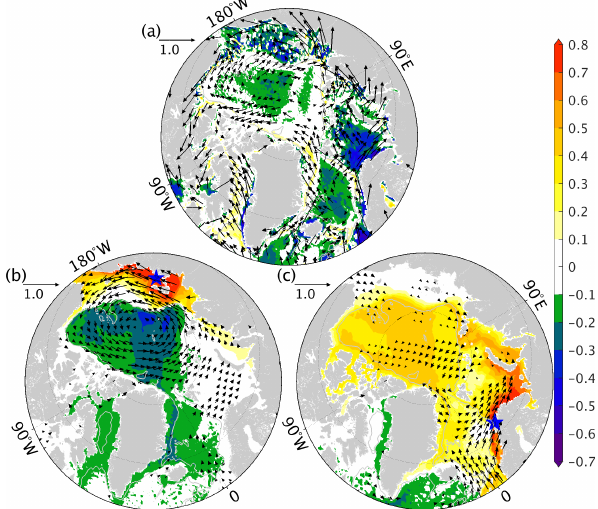
Figure 6. (a) Coefficients of the correlation between sea level anomalies and wind stress curl (shading), wind stress (vectors) at periods of < 30d. (b) Correlations of sea level anomalies in subre- gions of the East Siberian Sea (blue star in panel b ) to wind stress (vectors) and sea level anomalies (shading). Panel (c) is the same as panel (b) but for sea level anomalies in the Norwegian shelf (blue star in panel c ). Correlation coefficients with 95% significance lev- els are